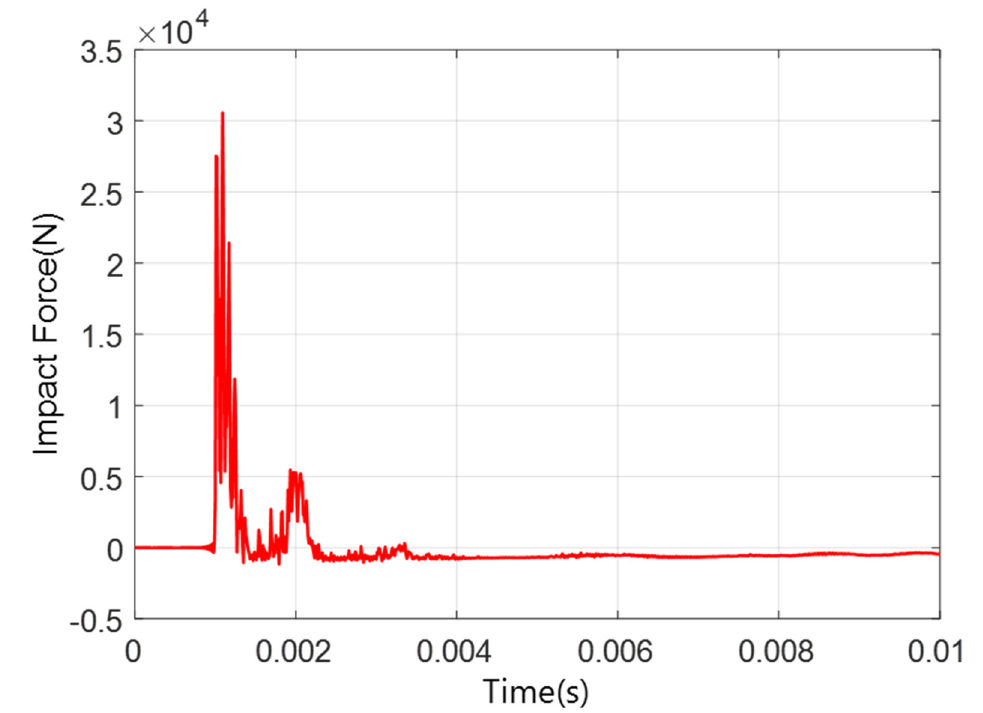
Figure 6. The high − frequency shock load signal from experiment.